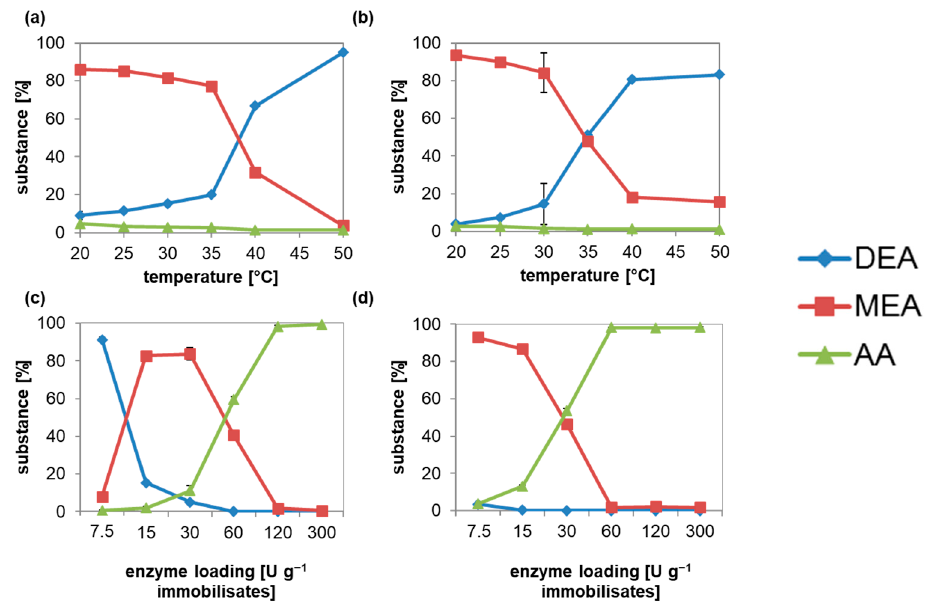
Figure 5. Minimization of AA formation in DEA hydrolysis catalyzed by ACut2-6hp adsorbed ( a , c ) or covalently bonded ( b , d ) in dependence of temperature during reaction ( a , b ) and enzyme loading ( c , d ). The activity of 7.5 U g − 1 corresponds to 1 mg protein g − 1 carrier of ACut2-6hp. Measurements were made in duplicate. Represented are the mean ± SD.